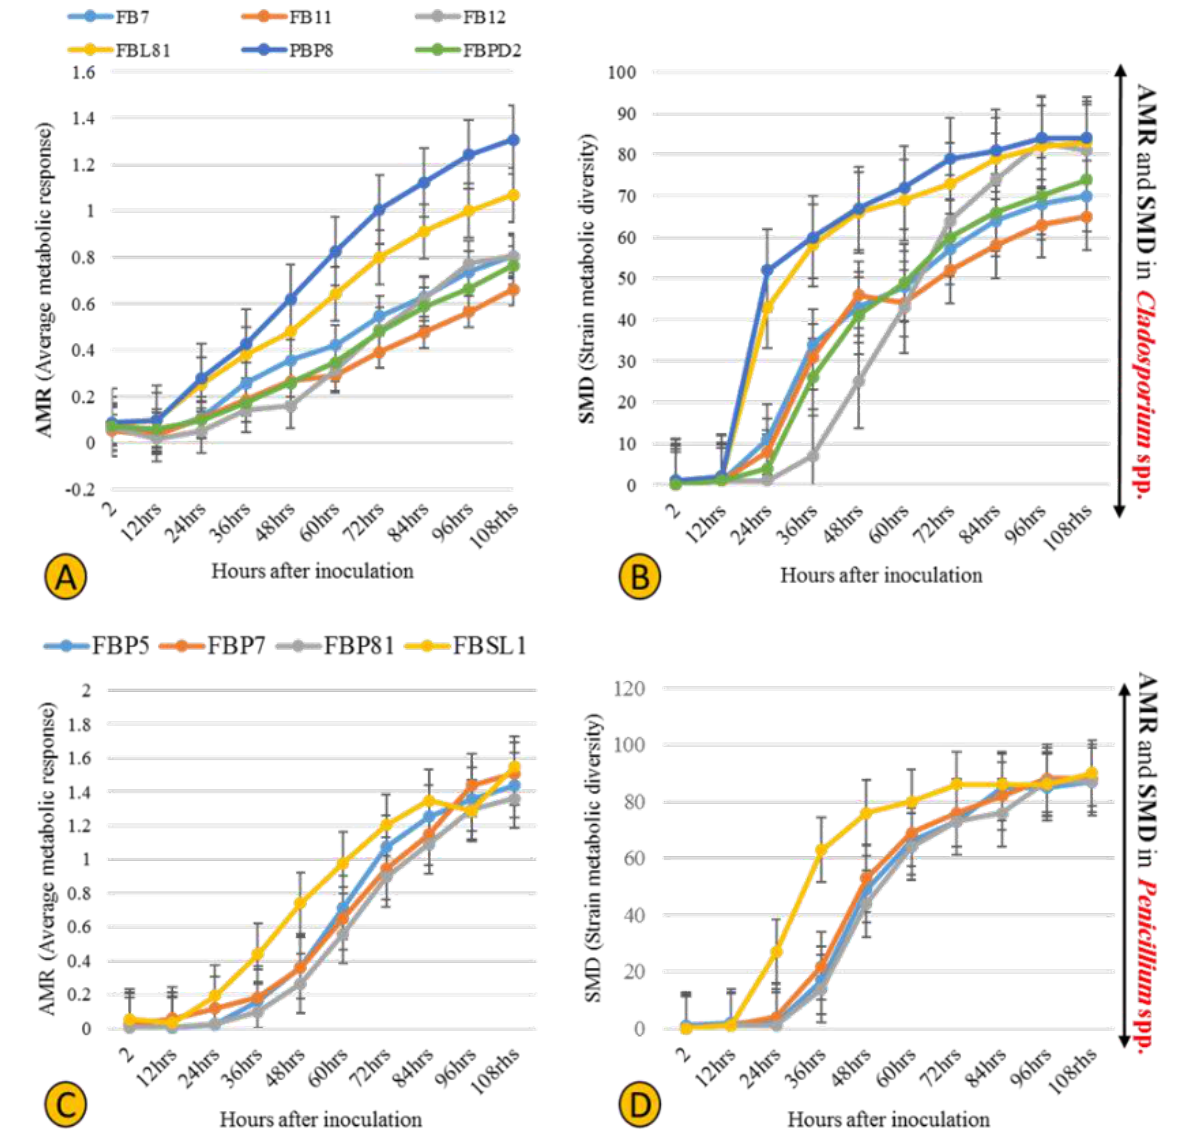
Figure 7. Physiological profiles of six Cladosporium and four Penicillium strains isolated in this study, with the AMR (average metabolic response) ( A , C ) and SMD (strain metabolic diversity) ( B , D ).